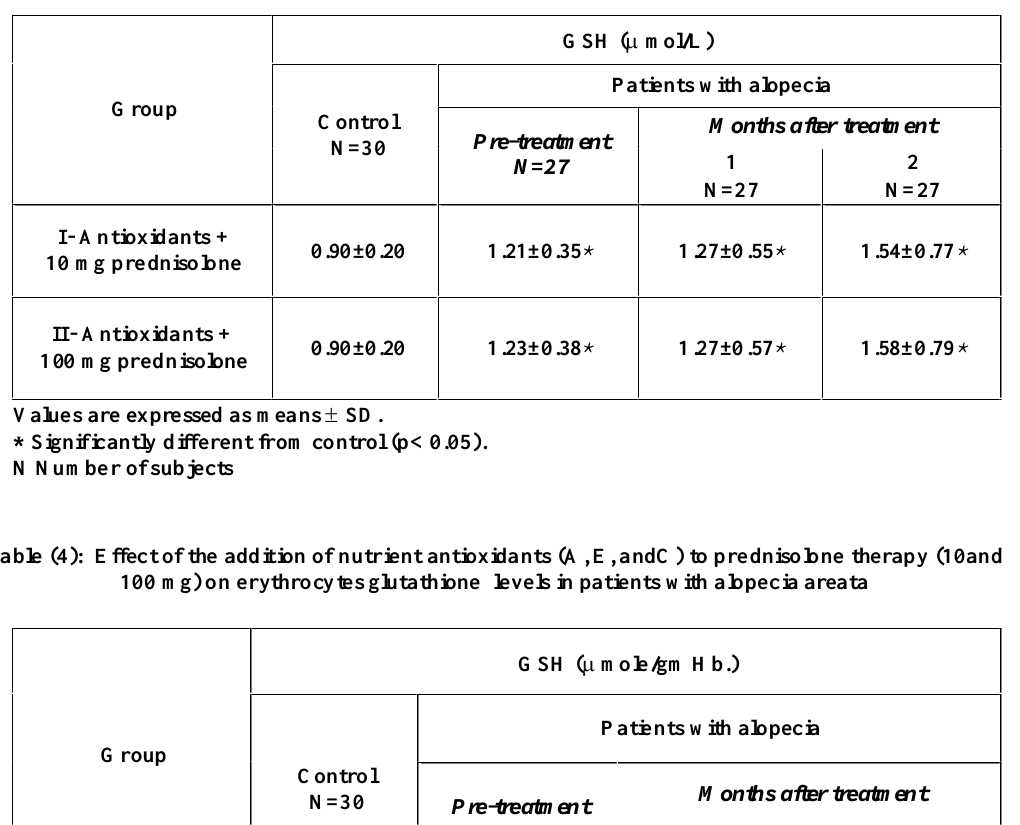
Table (3): Effect of the addition of nutrient antioxidants (A, E, &C) to prednisolone therapy